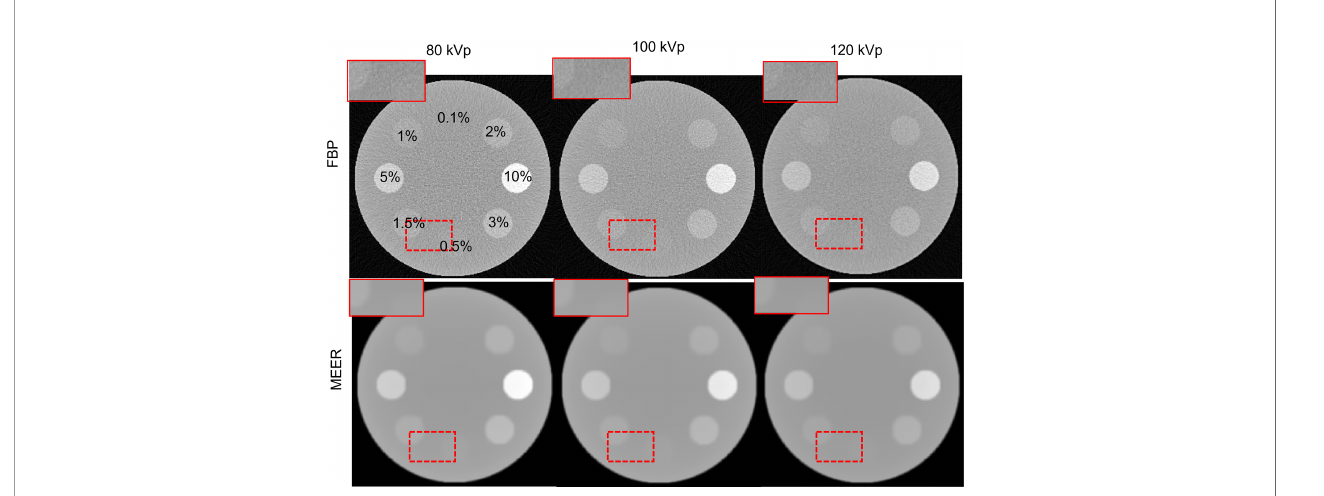
FIGURE 4 | Reconstructed CT images in the simulation study. Dashed rectangles indicate zoomed in view regions. The CT images are displayed at a window of [-500, 500 HU].